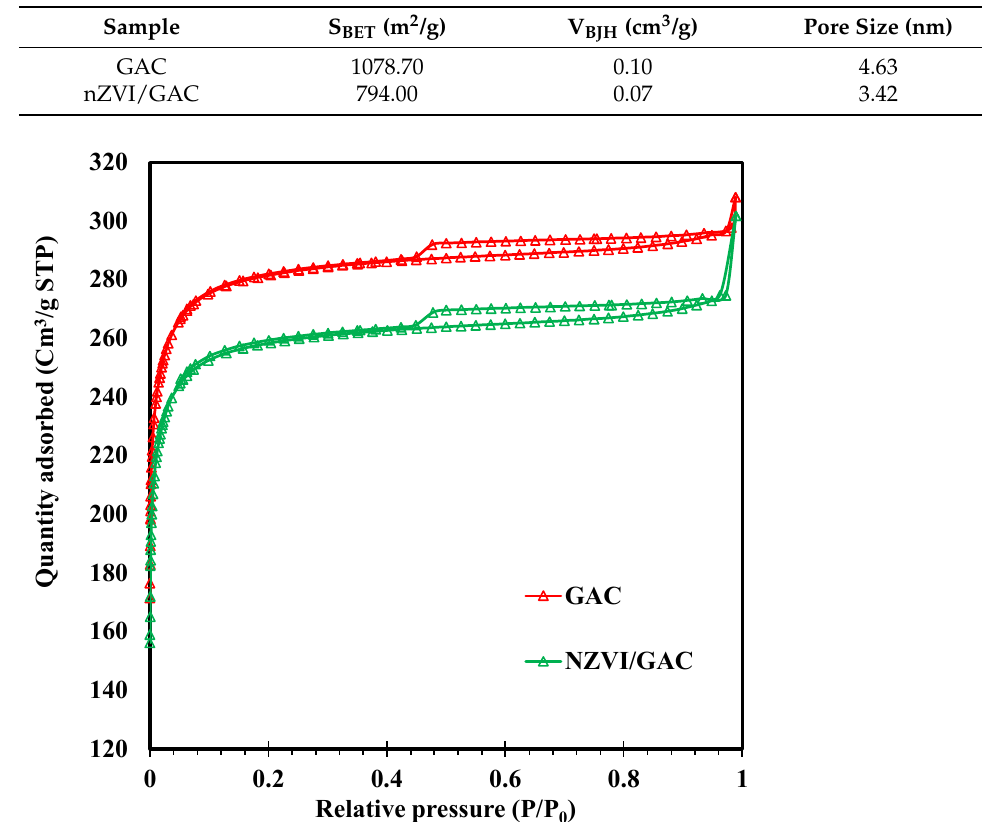
Figure 2. Nitrogen adsorption–desorption isotherms of GAC and GAC-supported nZVI.